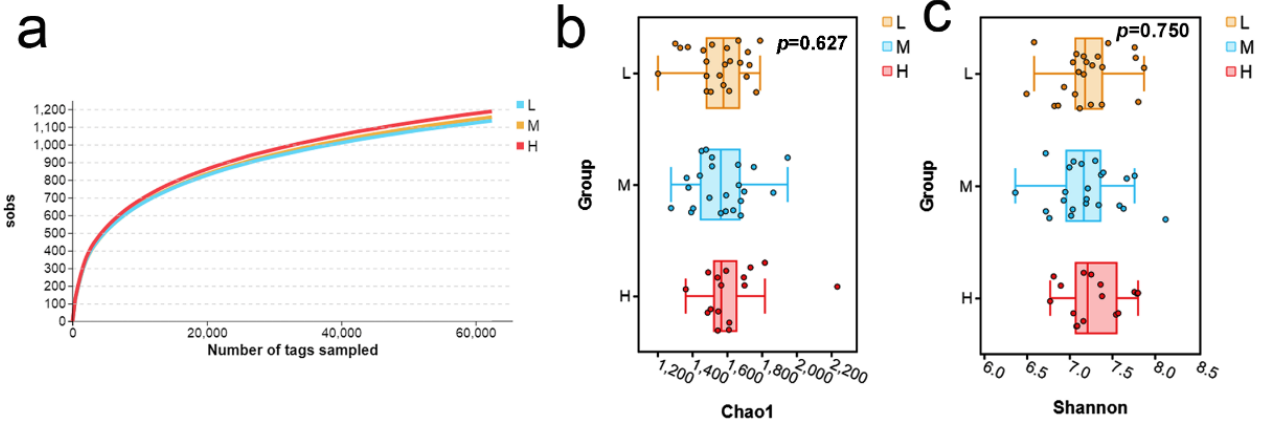
Figure 1. Alpha-diversity analysis of fecal microbes in each group. ( a ) Rarefaction curves. ( b , c ) Box- plot based on the Chao1 and Shannon index.